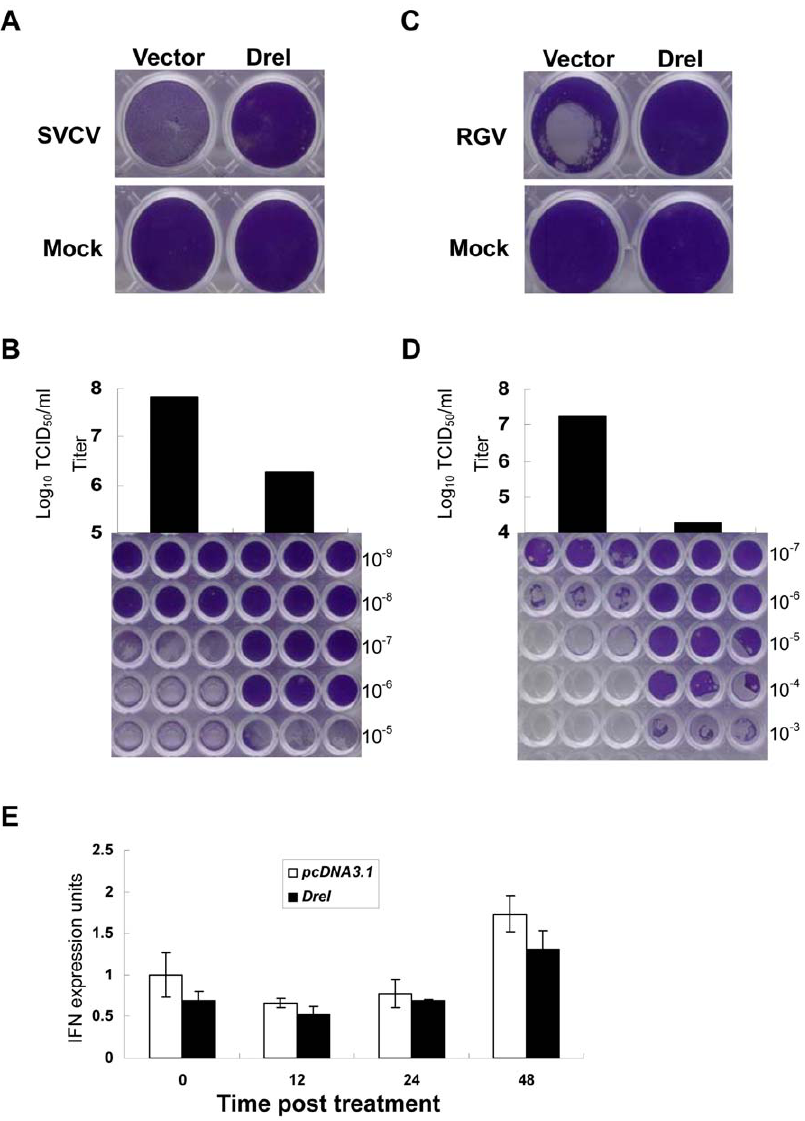
Figure 6. Overexpression of DreI induces powerful antiviral immunity. (A, C) EPC cells seeded in 24-well plates overnight were transfcted with 0.5 m g DreI plasmid or empty vector as a control. At 24 h postransfection, EPC cells were infected with SVCV or RGV at a dose of 10 TCID50 per well for 5 days at 25 u C. Then Cell monolayers were stained with crystal violet. (B, D) The culture supernatants from cells infected with SVCV and RGV were collected and the viral titers were measured by standard TCID 50 method. The CPE caused by SVCV or RGV in viral titer measurement assays was also presented. The results are the representative of two independent experiments. (E) EPC cells were transfected with empty vector or DreI plasmid and were sampled at the indicated times. The relative transcript level of IFN was detected by real-time PCR and normalized to the expression of b - actin. Error bars represent SDs obtained by measuring each sample in triplicate.